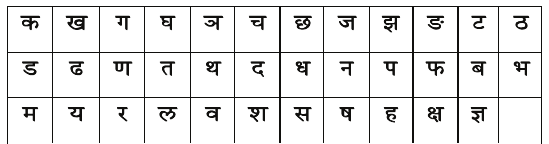
Figure 2. Isolated strokes and symbols in the